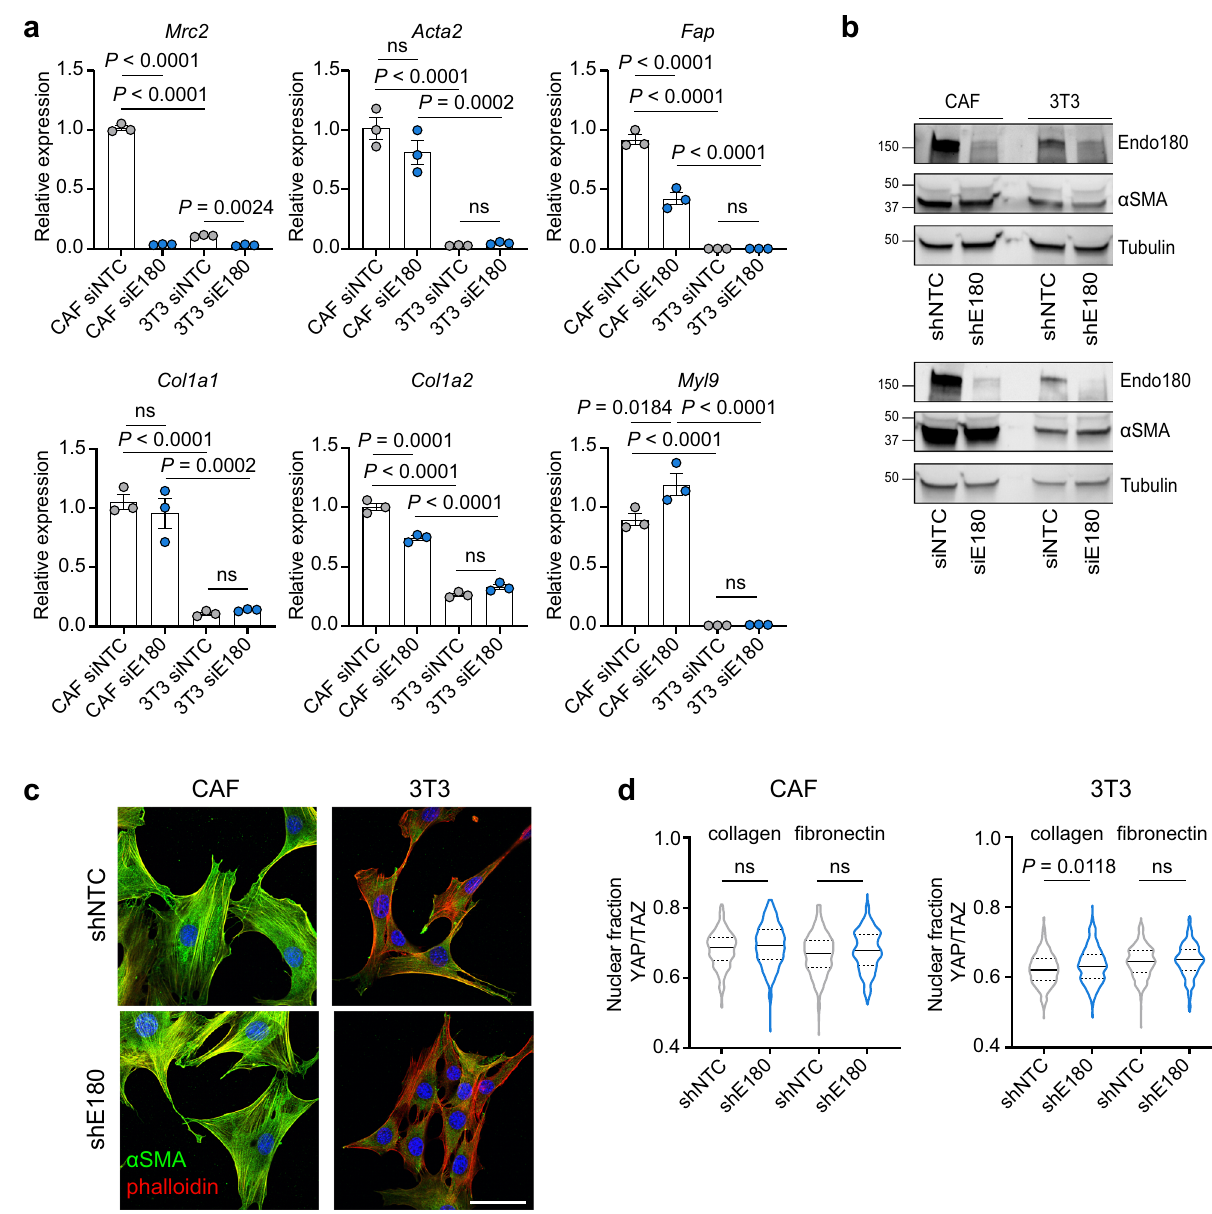
Fig. 5 Endo180-de fi cient fi broblasts retain markers of activation. a RT-qPCR analysis of contractility and activation markers in siNTC and siE180 transfected CAFs and 3T3 cells ( n = 3, mean values ±SEM, one-way ANOVA, Sidak post-hoc test). b Western blot analysis of Endo180 and α SMA in shNTC/shE180 transduced (top panel) and siNTC/siE180 transfected (bottom panel) CAFs and 3T3s. Molecular size markers are in kDa. c Confocal images of shNTC and shE180 transduced CAFs (left panel) and 3T3s (right panel) stained for α SMA (green), phalloidin (red) and DAPI (scale bar, 50 µ m). d siNTC and siE180 transfected CAFs plated on collagen-coated or fi bronectin-coated glass 24-well plates for 24 h. YAP/TAZ immuno fl uorescence intensity was quanti fi ed in nuclear and cytoplasmic compartments by high content imaging analysis. Violin plots, solid lines indicate median expression levels, dotted lines indicate upper and lower quartiles ( n = 400, Kruskal – Wallis test, Dunn ’ s correction). Non-signi fi cant (ns) P values > 0.05. Source data are provided as a Source Data fi